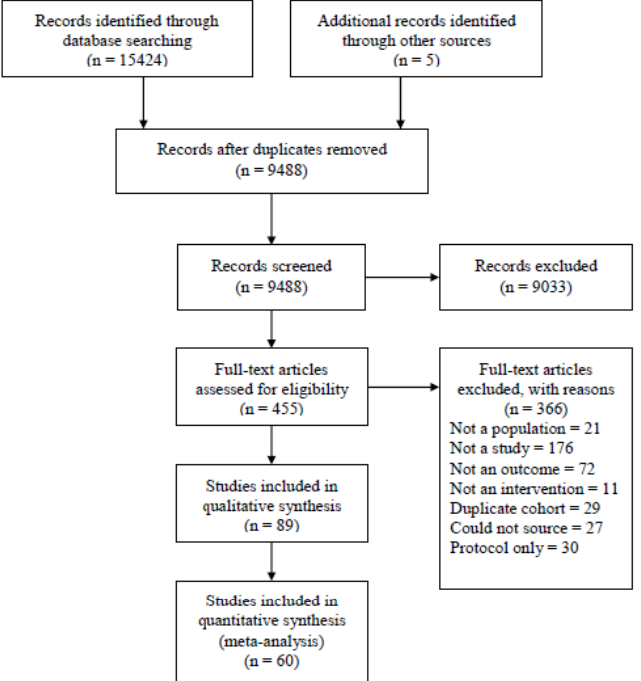
Figure 1. PRISMA flowchart of study selection.